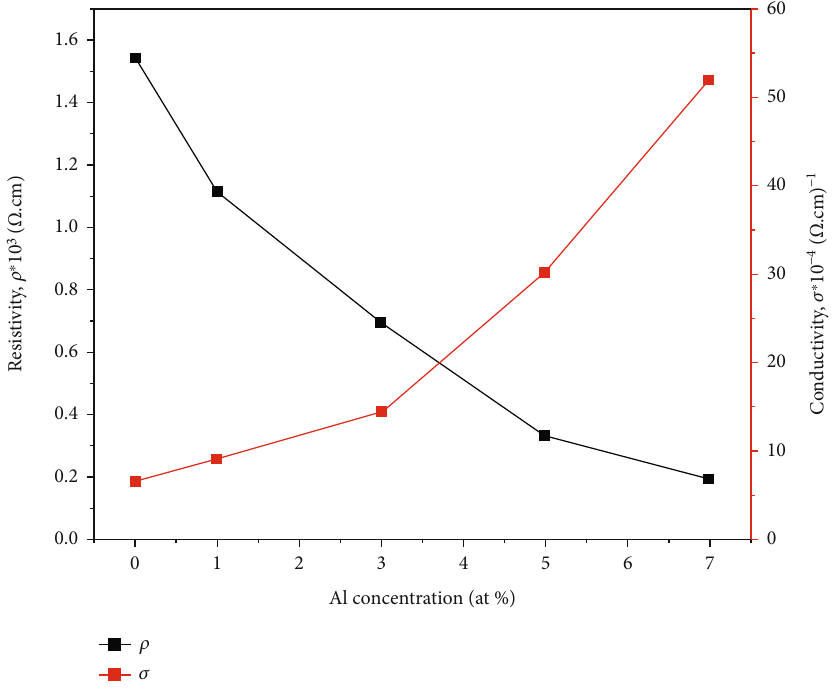
Figure 12: Electrical resistivity and conductivity of Al-Ni-codoped SnO